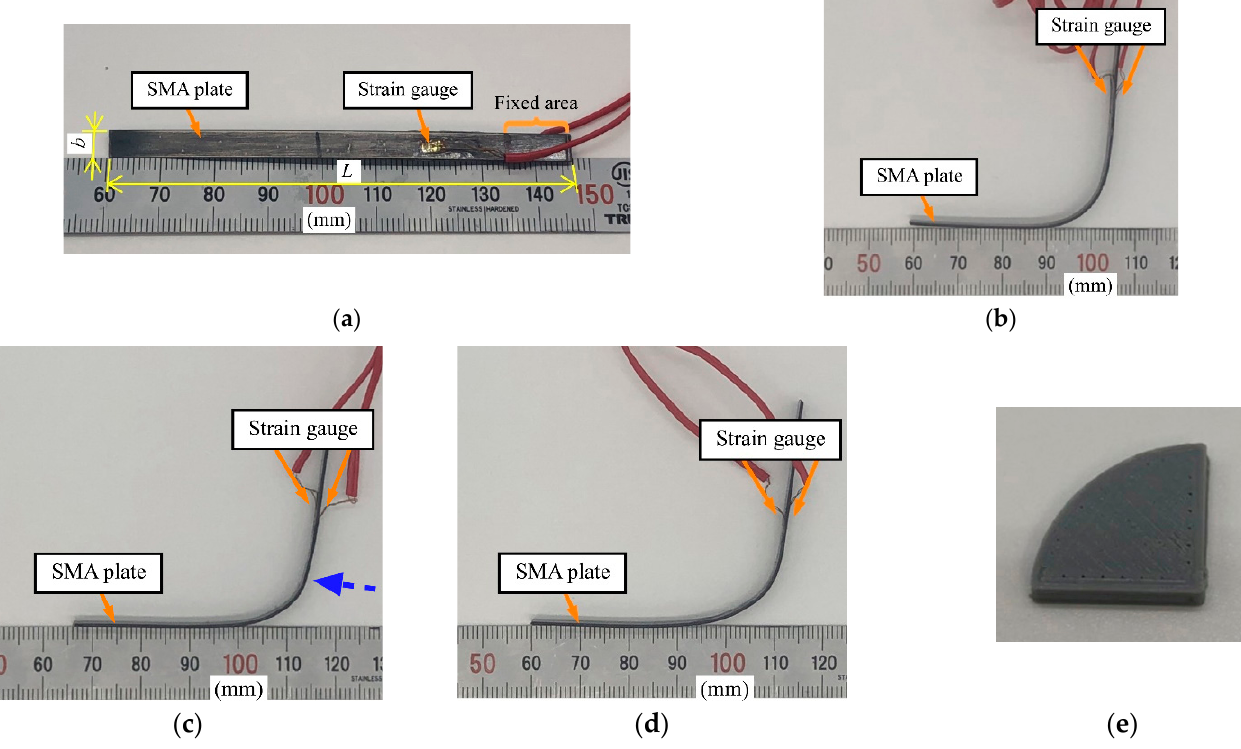
Figure 5. Prototype SMA FS. ( a ) Before bending. ( b ) Sample no. 1 ( x 2 = 23.8 mm). ( c ) Sample no. 2 ( x 2 = 21.1 mm). ( d ) Sample no. 3 ( x 2 = 18.9 mm). ( e ) Cylindrical jig used to bend SMA plates. Table 1. Dimensions of prototype SMA FS (average ± standard deviation from ten measurements). Sample No. 1